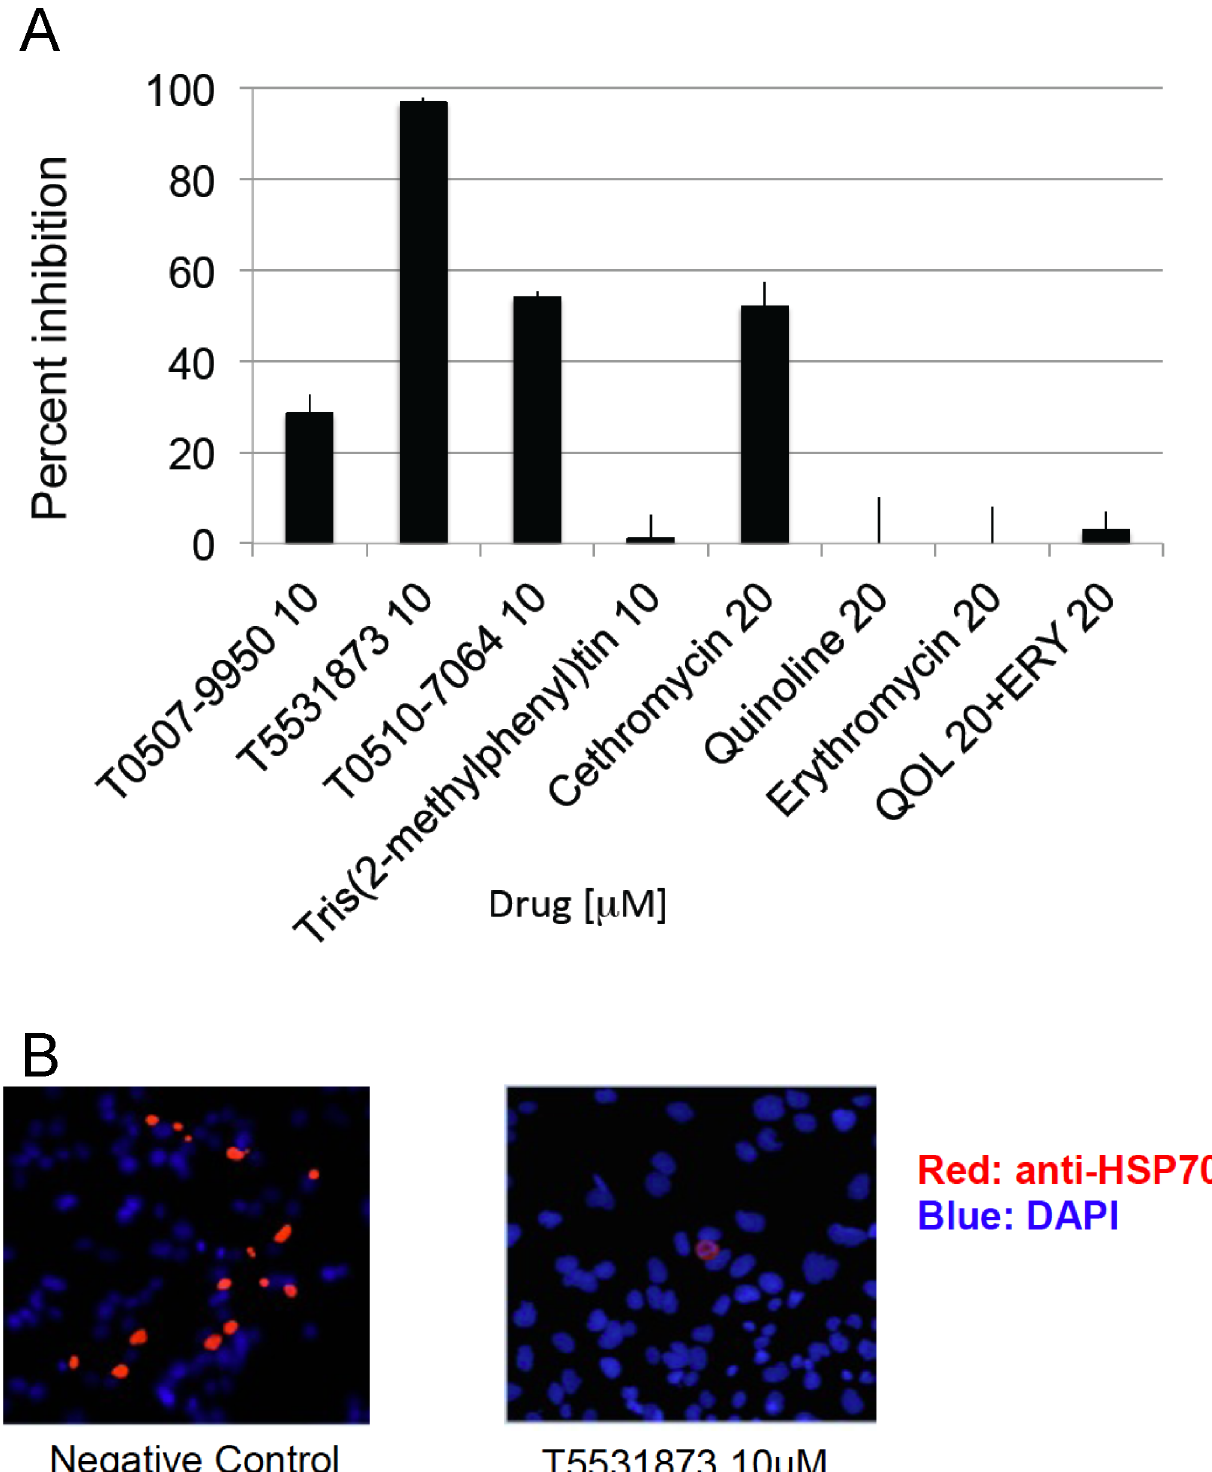
Fig 3. in vitro inhibition of liver stage malaria. A. Three of the new compounds indicated 30%, 96% and 55% inhibition while cethromycin alone at 20 μ M had 54% inhibition. The individual components of cethromycin-quinoline and erythromycin, were inactive. Error is average of duplicate wells performed in two independent biologic experiments with different preparations of sporozoites. B . Microscopic image taken at 20x magnification of near 95% inhibition by T5531873. 50,000 Hepa1-6 cells were seeded in each well 24 hrs prior to infection with ~60,000 P . berghei sporozoites. The 2E6 anti-HSP70 antibody was used for immunofluorescent numeration of infected